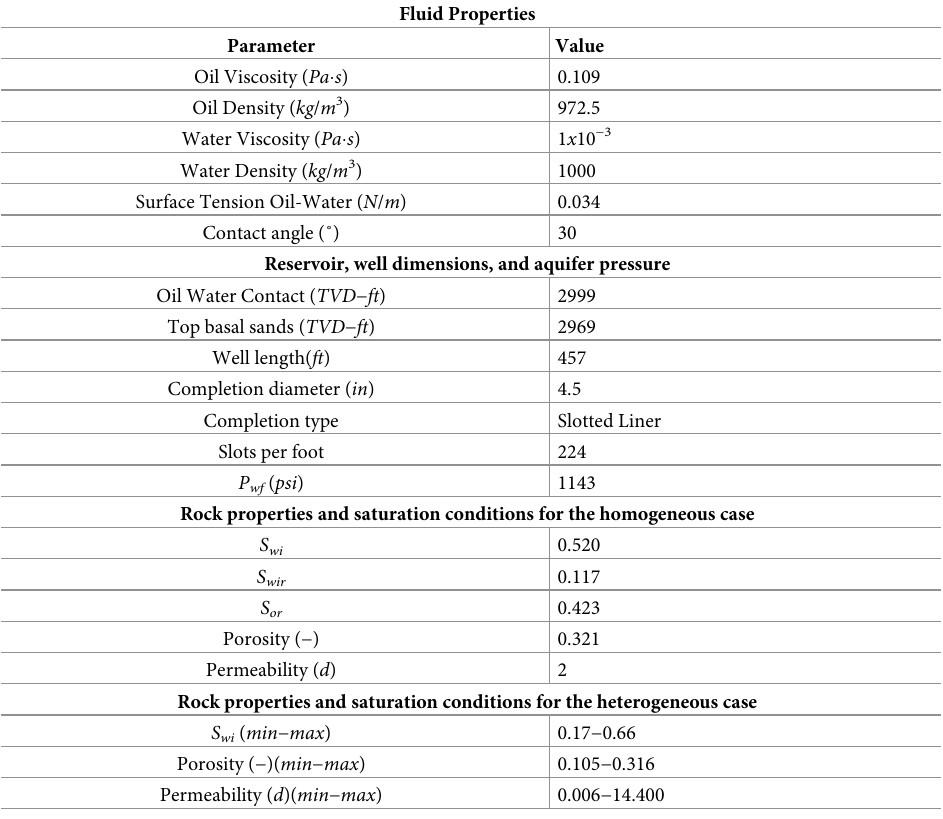
Finally, a sensitivity analysis was conducted varying the oil and rock physical properties to determine if the numerical model could predict the fluid dynamics’ differences near the well- bore due to these variations. For example, the displacement stability is strongly influenced by variations in the permeability and the phases’ viscosity contrast. Both variables ultimately affect the mobility ratio and, consequently, the strength of the viscous forces. Therefore, Table 2 presents the matrix of more than 25 numerical experiments for this sensitivity analysis. It must be pointed out that this sensitivity analysis was conducted considering as base parame- ters the same ones presented in Table 3. Therefore, the rock and fluid physical properties and the initial conditions presented in Table 3 were kept constant during the numerical experi- ments of Table 2. It must be pointed out that the sensitivity analysis considered homogeneous, or uniform, properties in the whole domain. Table 3. Physical properties obtained from field measurements and used in the CFD reservoir-scale